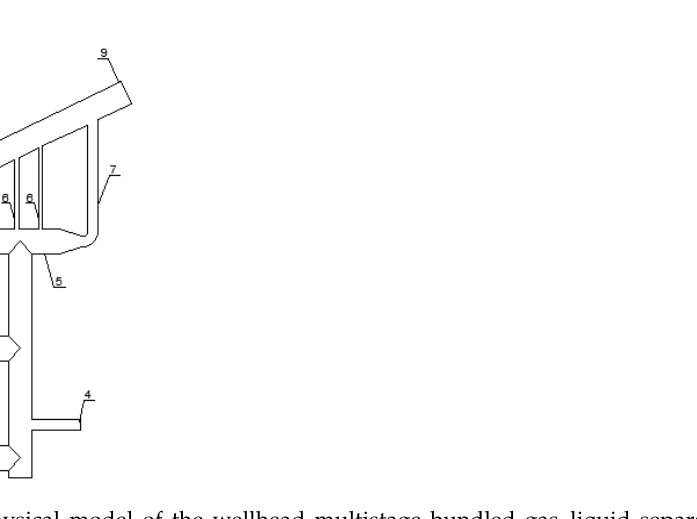
Figure 1. Simplified physical model of the wellhead multistage bundled gas–liquid separator. 1—